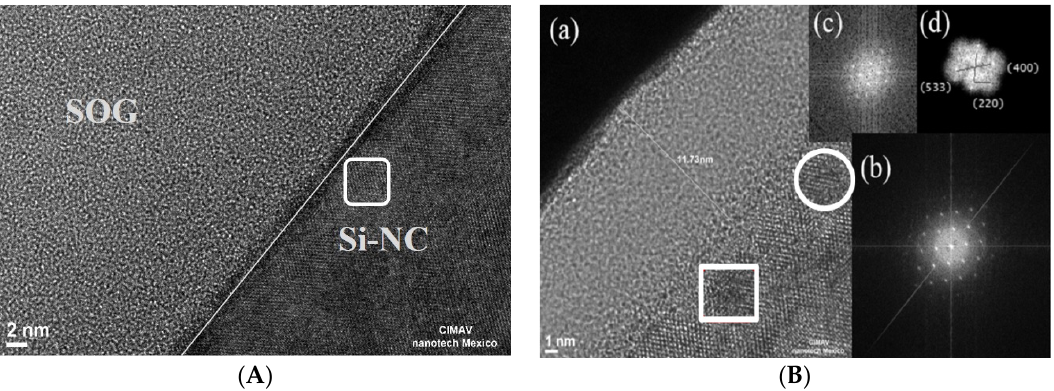
Figure 2. Cross ‐ section TEM (transmission electron microscopy) images of coated films with red Si ‐ NCs before ( A ) and after ( B ) thermal annealing at 1100 °C for 3 h in N 2 atmosphere. In both images, the white square marks the area of analysis where there are Si ‐ NCs. The insets of ( B ) are: ( a ) cross ‐ section TEM images; ( b ) FFT (Fast Fourier Transform); ( c ) the specific pattern of the white square area; and ( d ) the electrons diffraction planes of the white square area. The white circle in the